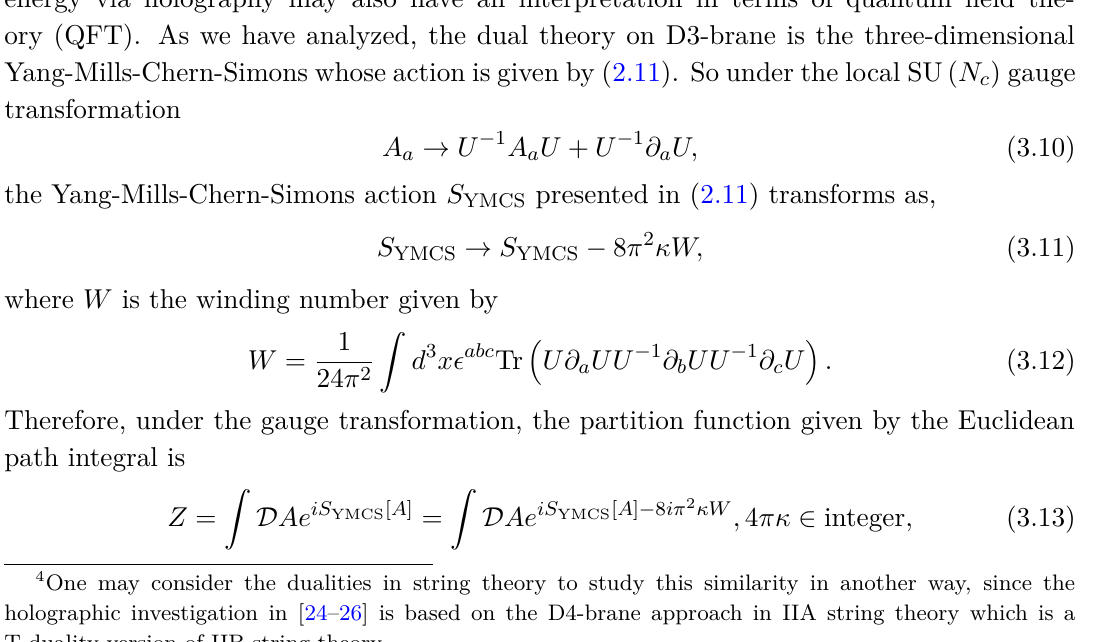
(cid:2) (cid:3) − 3 , − 1 and so 8 π 8 π